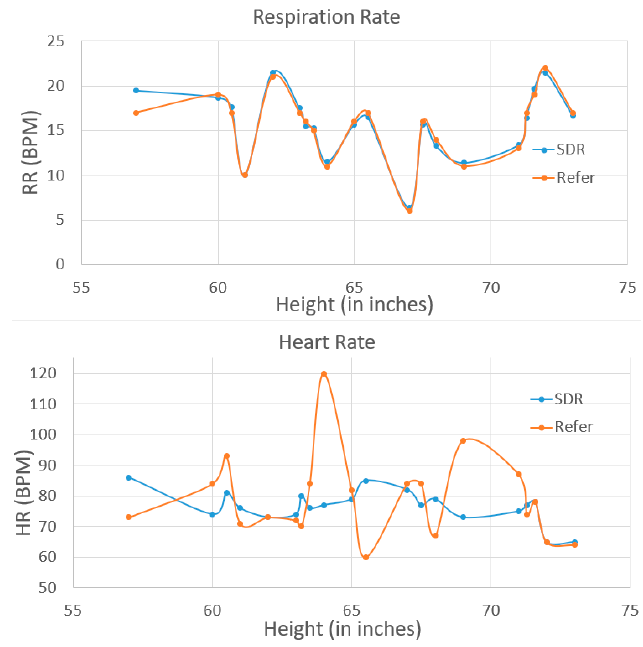
Figure 10. Clinical trial test data on 20 cases sorted by weight.